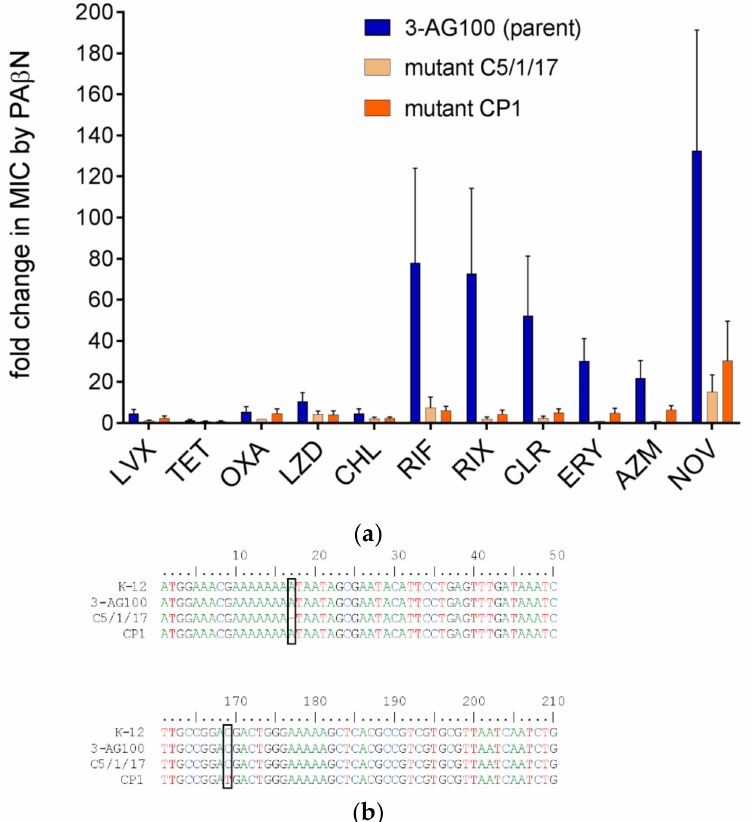
Figure 1. Phe-Arg- β -naphthylamide (PA β N)-resistant mutants versus parental E. coli 3-AG100 ( a ) PA β N efficacies with drugs shown as ratios of minimum inhibitory concentrations (MICs)